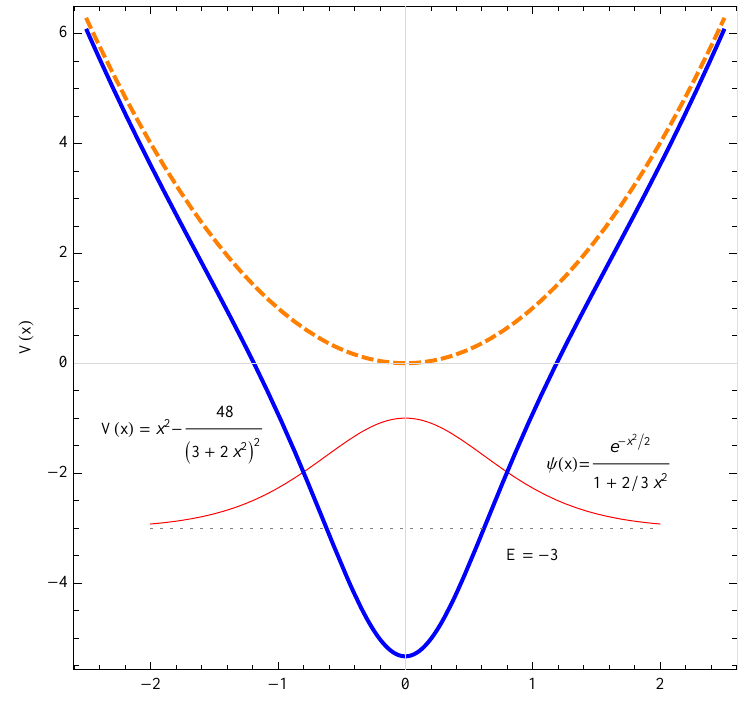
Figure 2. The anharmonic potential (solid line), the unperturbed harmonic potential energy curves and the ground state wave function corresponding to ground state energy E = − 3